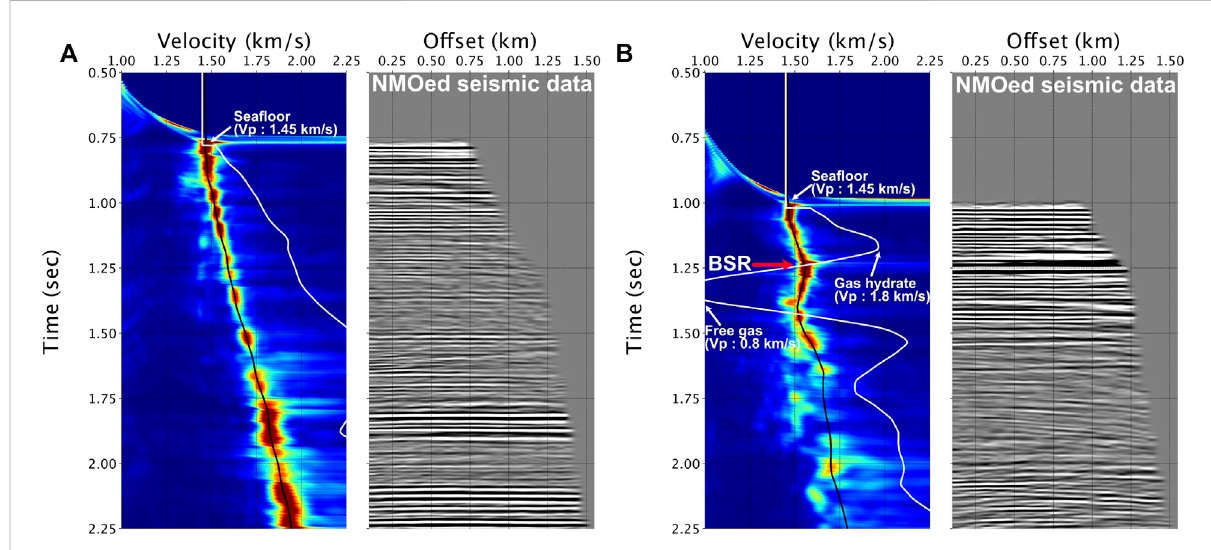
FIGURE 4 Velocitysemblancepanel(left)andNMO-correctedseismicdata(right)fortheiterativemigrationvelocityanalysis. (A) istheareawithoutaBSR, and (B) is the area with a